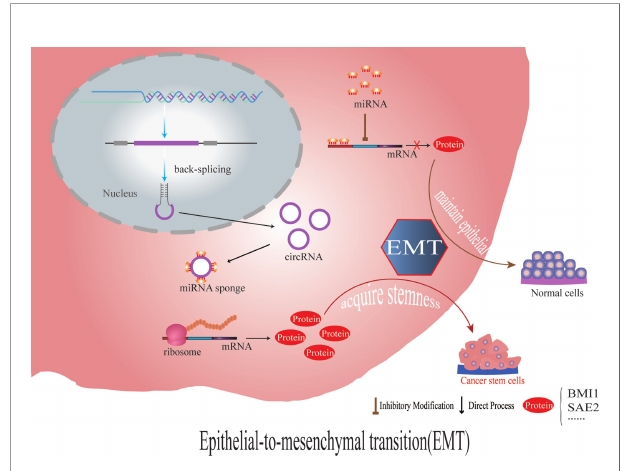
FIGURE 3 | CircRNAs regulate the stem cells of tumor cells by affecting the expression of EMT- and stemness-related proteins, which leads to chemotherapy